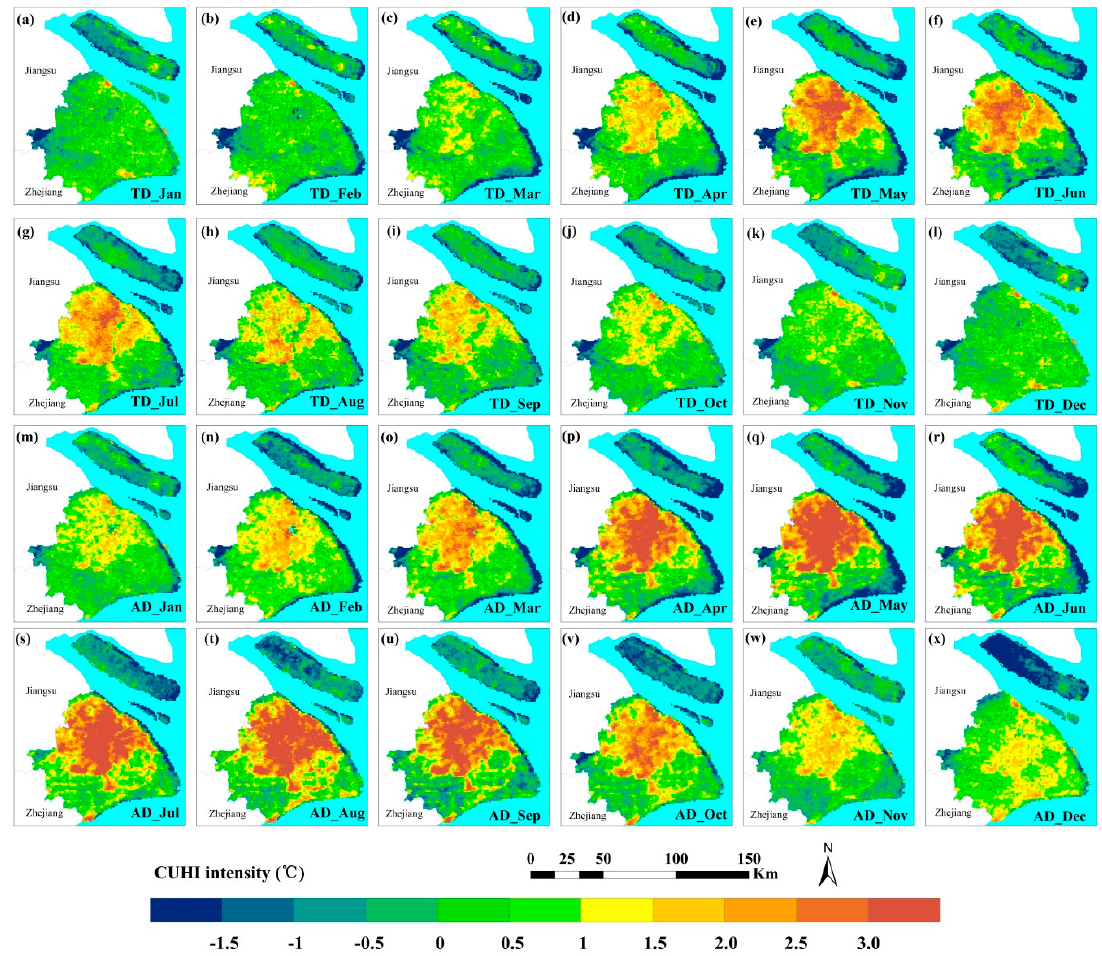
Figure 8. Climatological maps of monthly mean daytime CUHI intensity calculated form satellite-estimated air temperature. ( a – l ) each month at the Terra daytime overpass (TD ~ 10:30) during the period 2000–2013; and ( m – x ) each month at Aqua daytime overpass (AD ~ 13:30) during the period 2002–2013 over Shanghai.